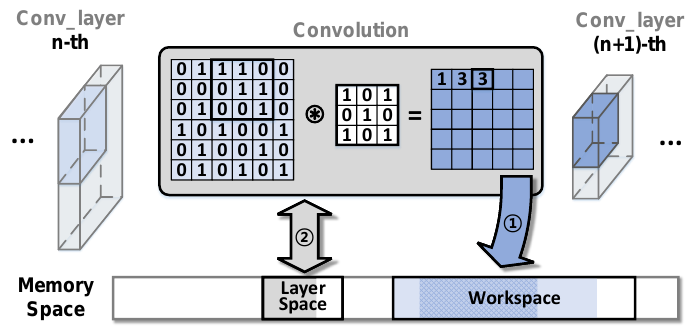
Figure 5. Forwarding procedure and its memory access